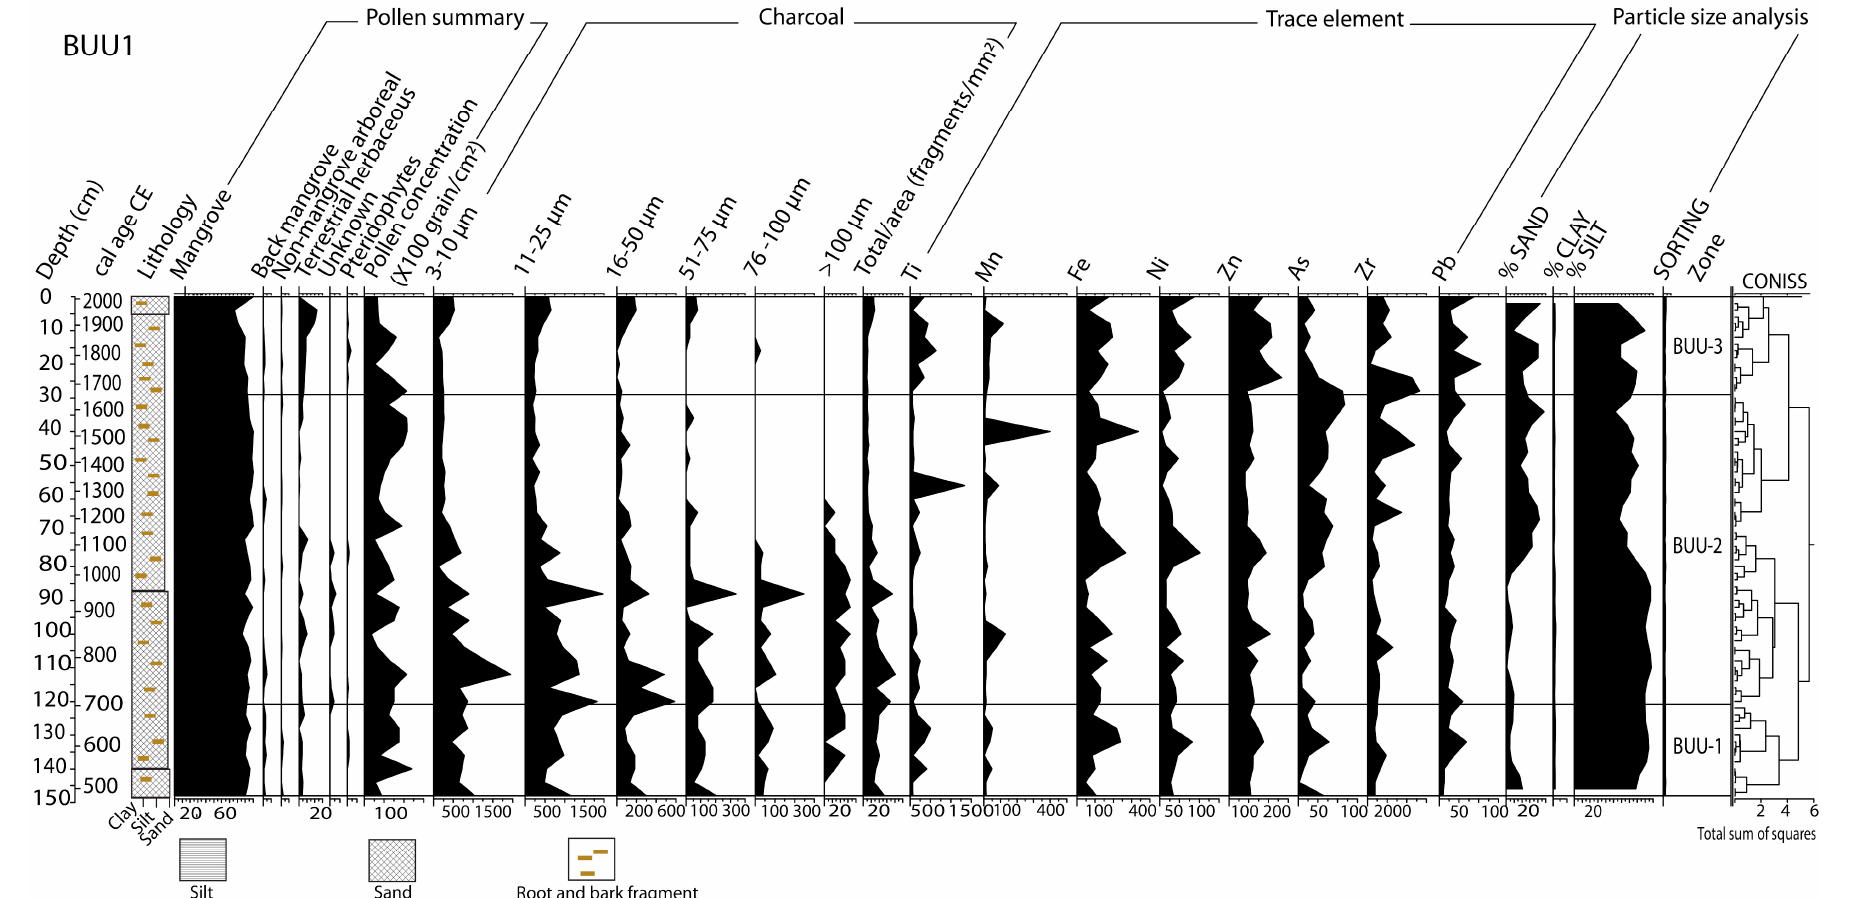
Figure 8. Frequency plot showing pollen summary, charcoal, trace elements and particle size data from BUU1 core. Zonation is based on a cluster analysis of pollen data.